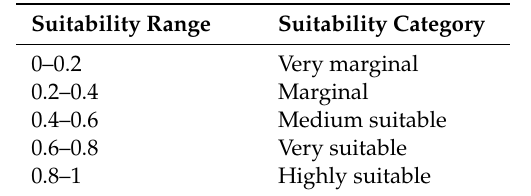
Table 6. Interpretation of the suitability results [66].